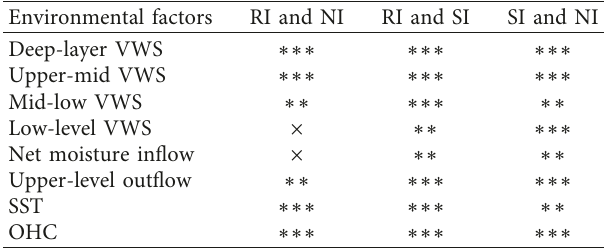
Table 2: Significant differences between the three intensification